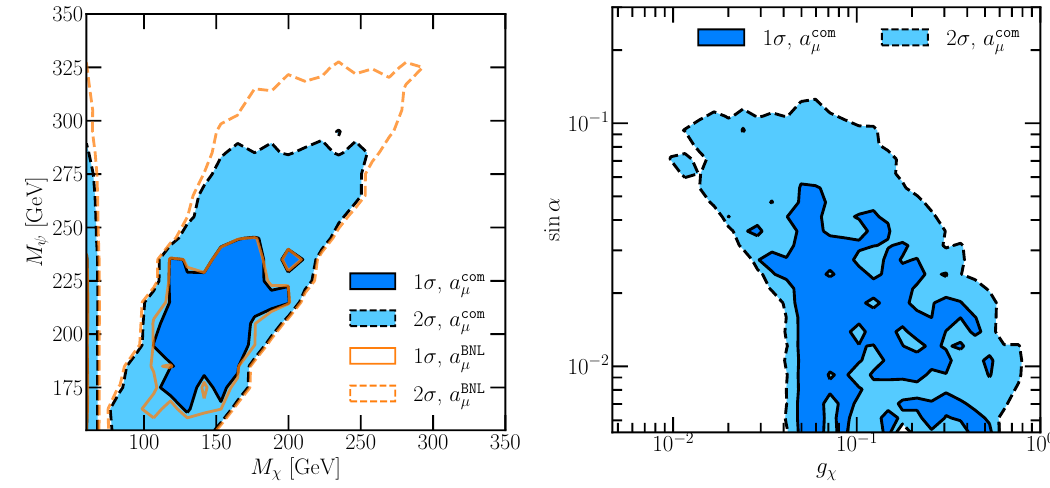
Figure 5 . Likelihood distribution in the ( M χ , M ψ ) plane (left) and ( g χ , sin α ) plane (right). Colors and constraints are as described in figure 2.